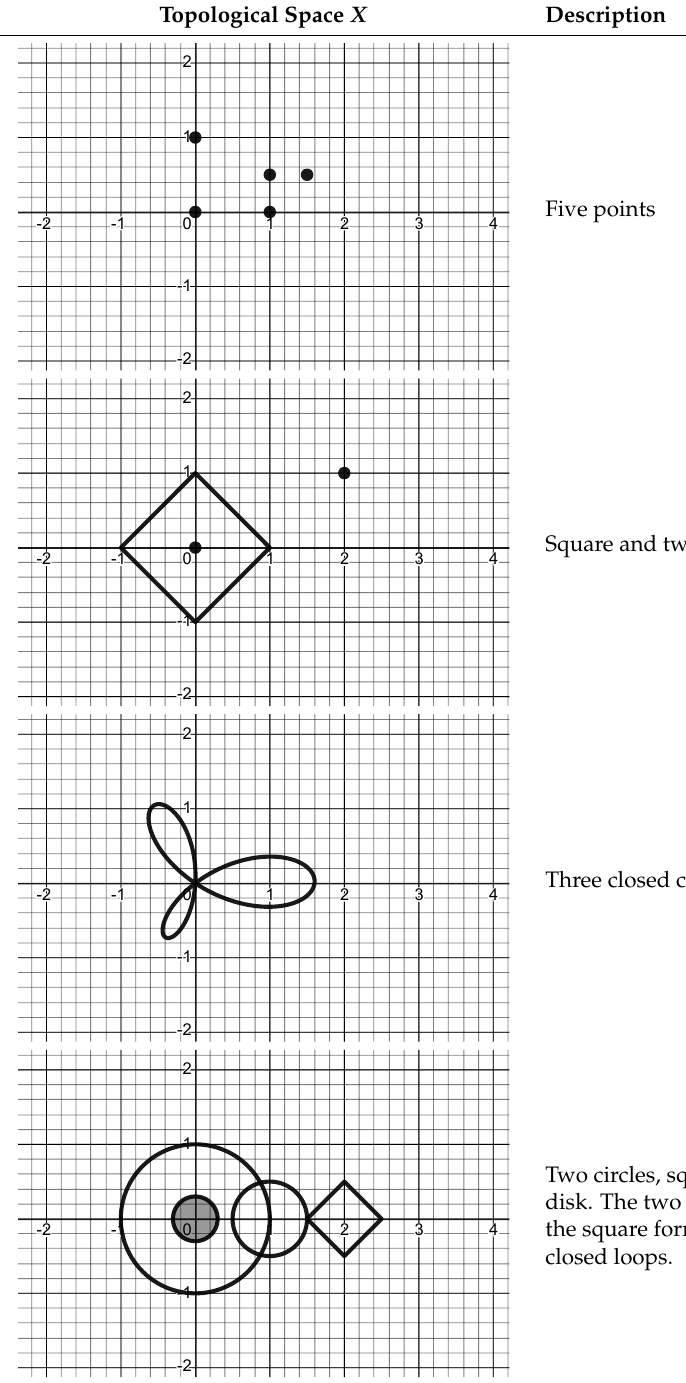
Table 1. Some topological spaces and their Betti